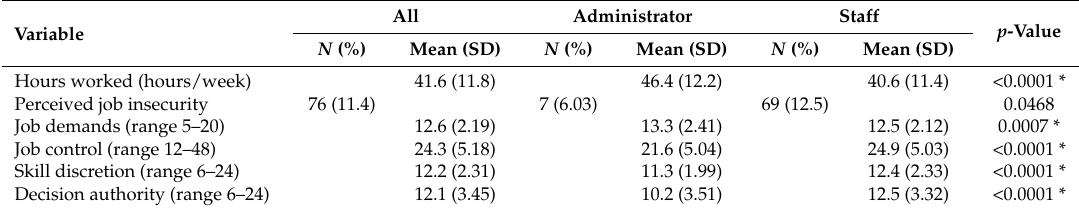
Table 4. Job-related health risk